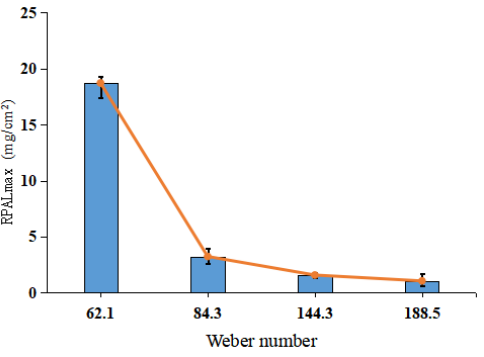
Figure 8. Relationship between surface tension of liquid and droplet retention for litchi leaves.